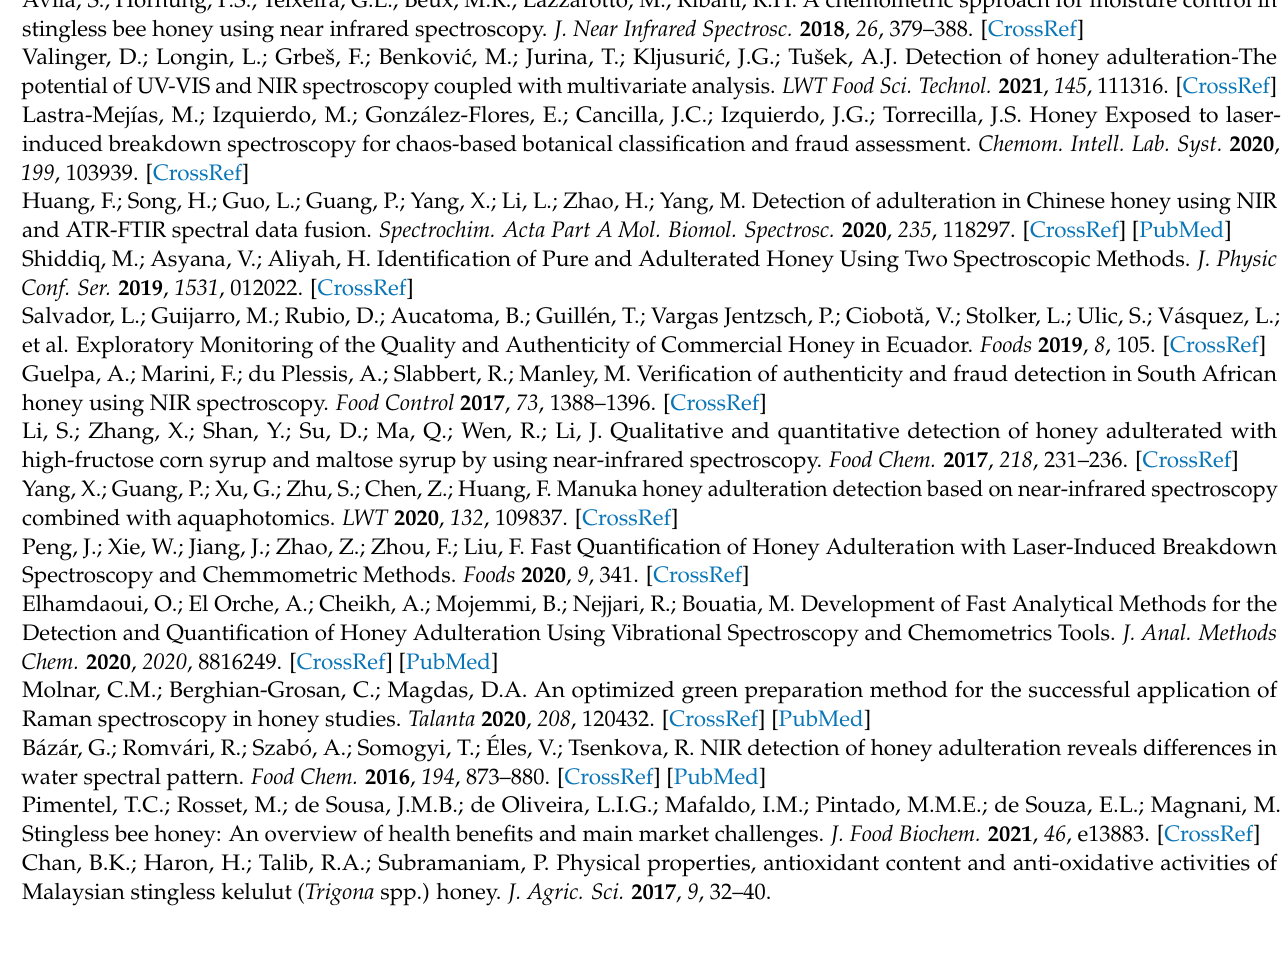
showing the variation of color of the samples ( n = 31). Figure S2. Zoom-in view of CIE x, y chromaticity diagram of the samples ( n = 31). Figure S3. 2D scores plot of PC1 vs. PC2 of the samples ( n = 31). Figure S4. 2D scores plot of PC1 vs. PC3 of the samples ( n = 31). Figure S5. 2D scores plot of PC2 vs. PC3 of the samples ( n =